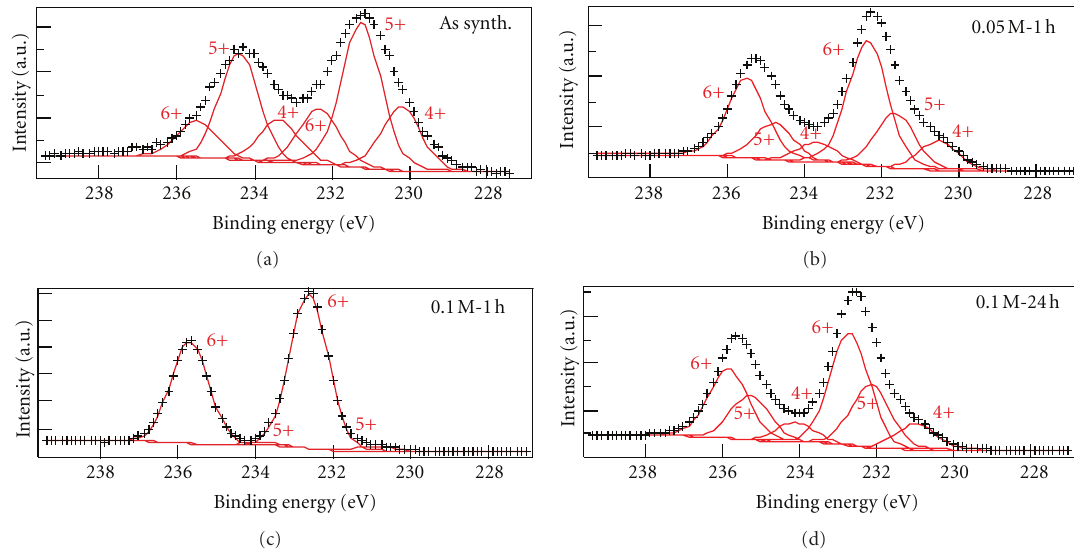
Figure 3: E ff ect of chemical oxidation conditions on MoO x nanoparticle stoichiometry. (a) Mo 3d XPS spectra of as-synthesized npMoO x on ITO (crosses) and curve fit (solid), showing mixed oxidation states with contributions from Mo 5+ , Mo 4+ , and a small amount of Mo 6+ . (b) Mo 3d XPS spectra of npMoO x after chemical oxidation with 0.05 M H 2 O 2 for 1hr, showing mixed oxidation states with a majority of Mo 6+ oxidation state. (c) Mo 3d XPS spectra of npMoO x after chemical oxidation with 0.1 M H 2 O 2 for 1hr, showing almost complete oxidation to Mo 6+ oxidation state. (d) Mo 3d XPS spectra of npMoO x after chemical oxidation with 0.1 M H 2 O 2 for 24hr, showing mixed oxidation states with a majority of Mo 6+ oxidation